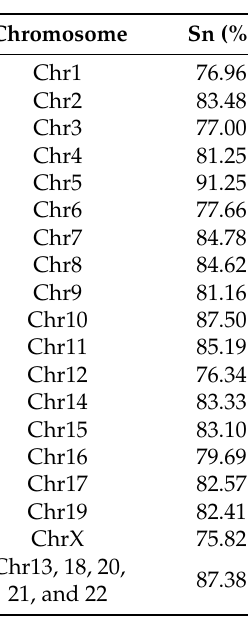
Table 3. The performance of our method using hold-out cross-validation on chromosome